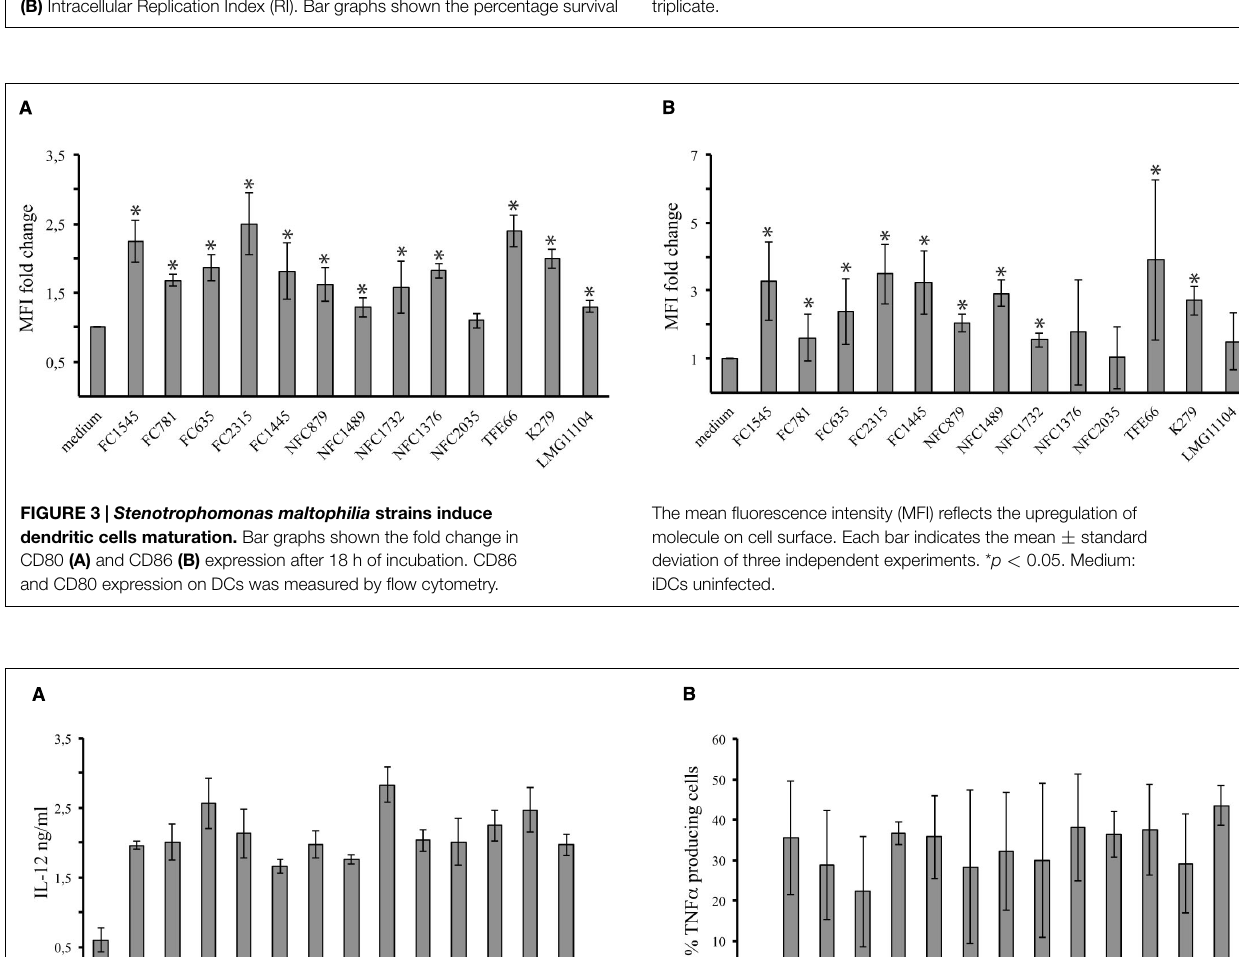
of S. maltophilia strains after 18 h of infection within DCs. Each bar indicates the mean value (cid:6) standard deviation of at least three independent experiments in triplicate.